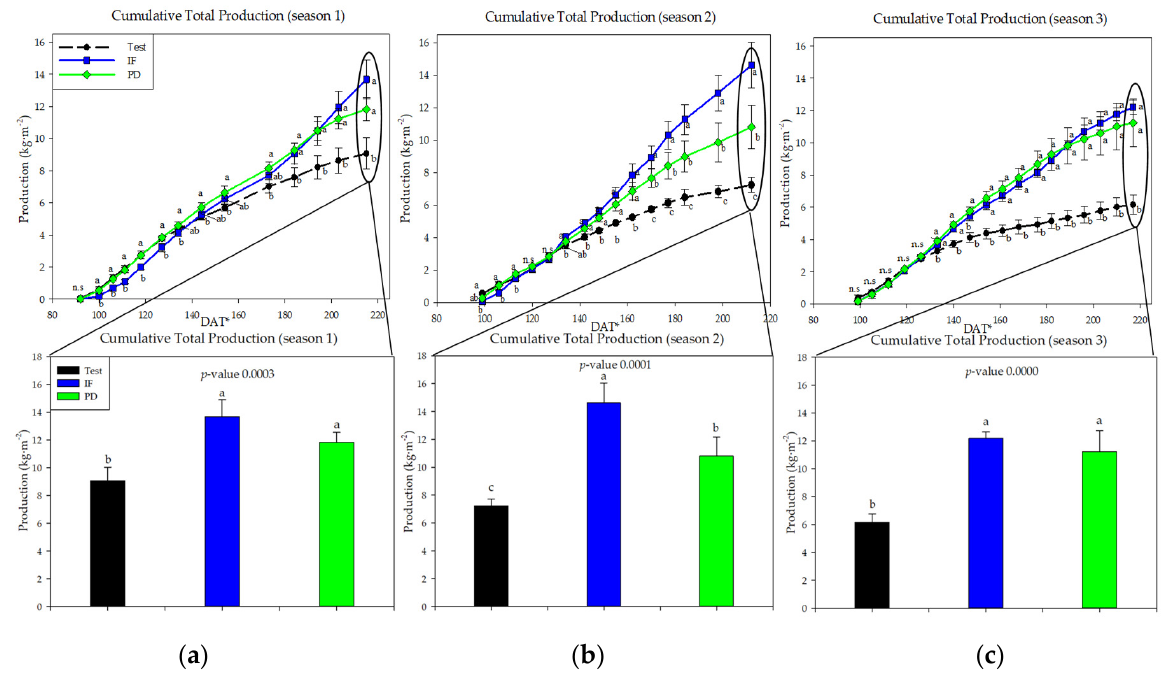
Figure 1. Cumulative tomato production in the three years of study (September–April cycles) as a function of crop nutrition: ( a ) Crop 1; ( b ): Crop 2; ( c ): Crop 3. Inorganic fertilization (IF); tomato plant debris (PD); no fertilization (test). Values (mean ± standard deviation). Different letters indicate significant differences ( p ≤ 0.05, Tukey’s HDS test). DAT: days after transplanting. Table 2. Tomato fruit yield and quality parameters in the three years of study (September–April cycles) as a function of crop nutrition. Values (mean ± standard deviation).